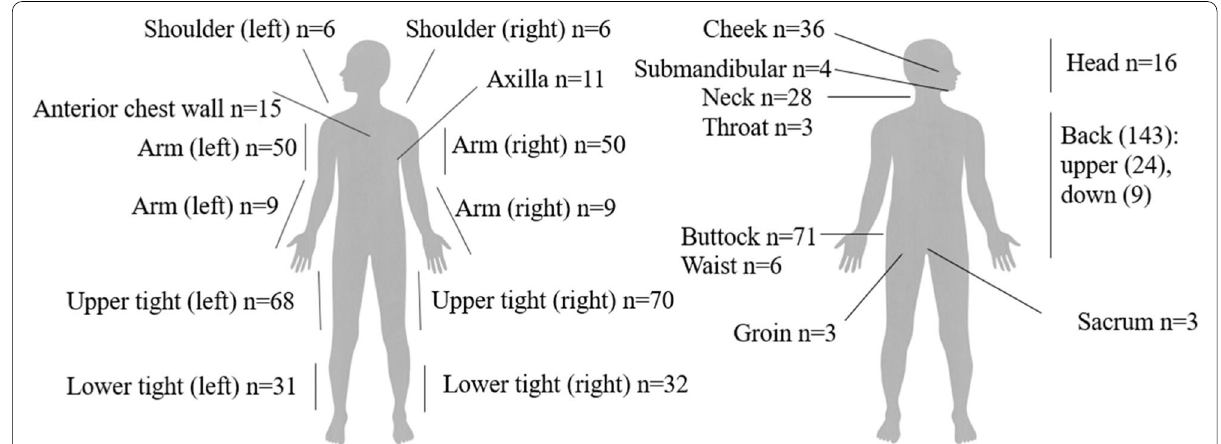
Fig. 2 Reported localisation of subcutaneous fat necrosis in patients ( n